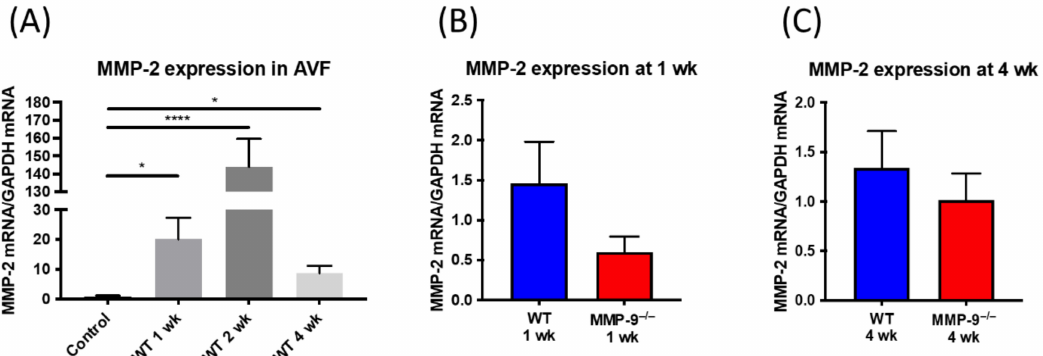
Figure 6. MMP-2 mRNA expression in AV fistula venous segment. ( A ) MMP-2 mRNA expression elevated after AV fistula creation comparing to contralateral veins sampled at 1 week, 2 weeks, and 4 weeks after AV fistula creation and the peak was at 2 weeks ( n = 6~7 in each time point). ( B,C ) The deletion of MMP-9 did not make compensatory elevation of MMP-2 at 1-week and 4-weeks post AVF creation. ( n = 6–7 in each group). * p < 0.05, **** p < 0.0001. Data presented as mean ± SEM and analyzed by one-way ANOVA followed by Bonferroni post hoc analysis for multiple comparison and Student’s t -test for comparison of